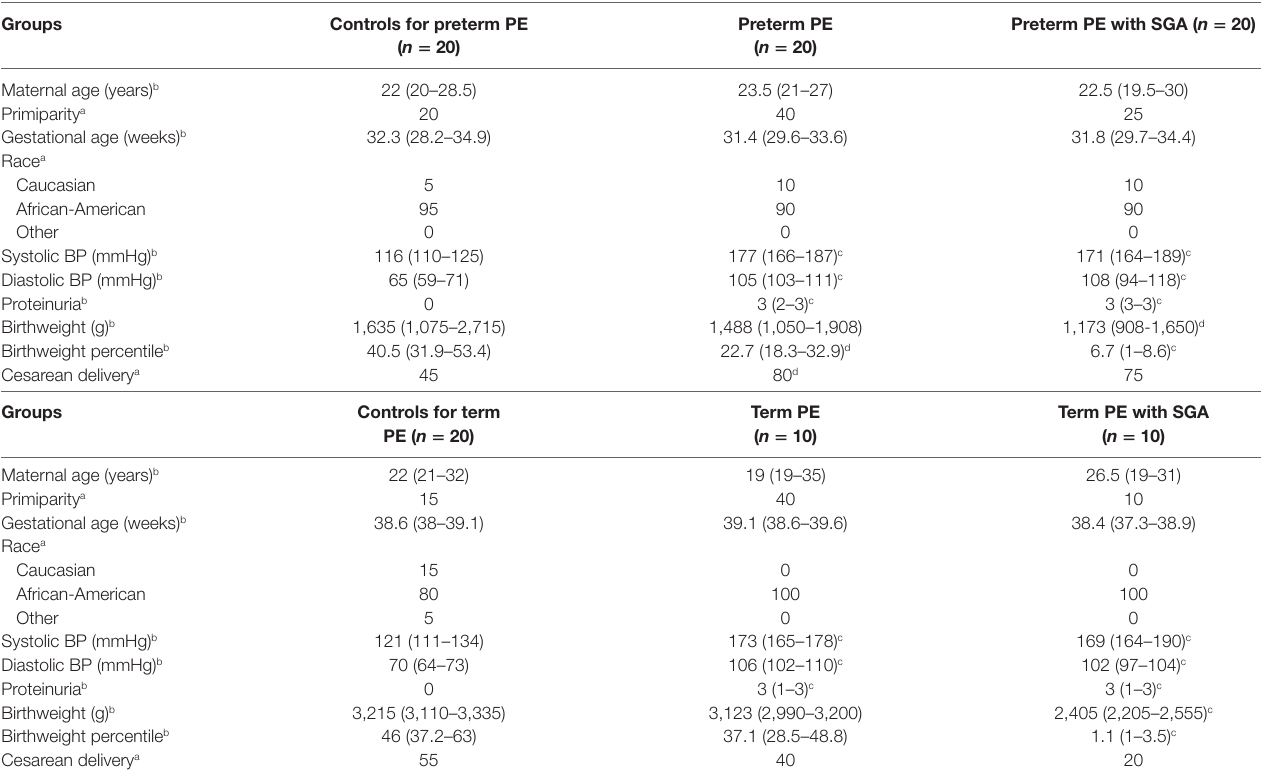
TaBle 2 | Demographics of American women included in the placental validation study.